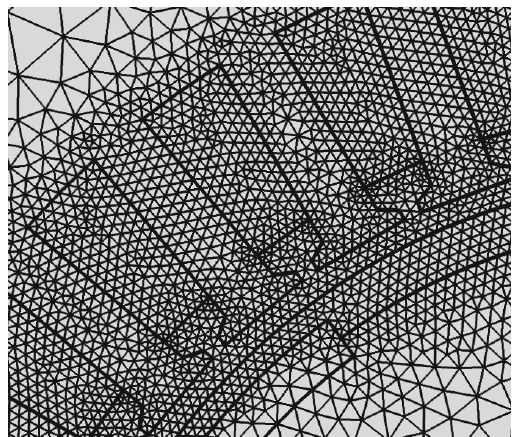
Fig. 6. The flux density distribution of the motor. The highest value can be observed at corner of the magnet, where B max = 1.6